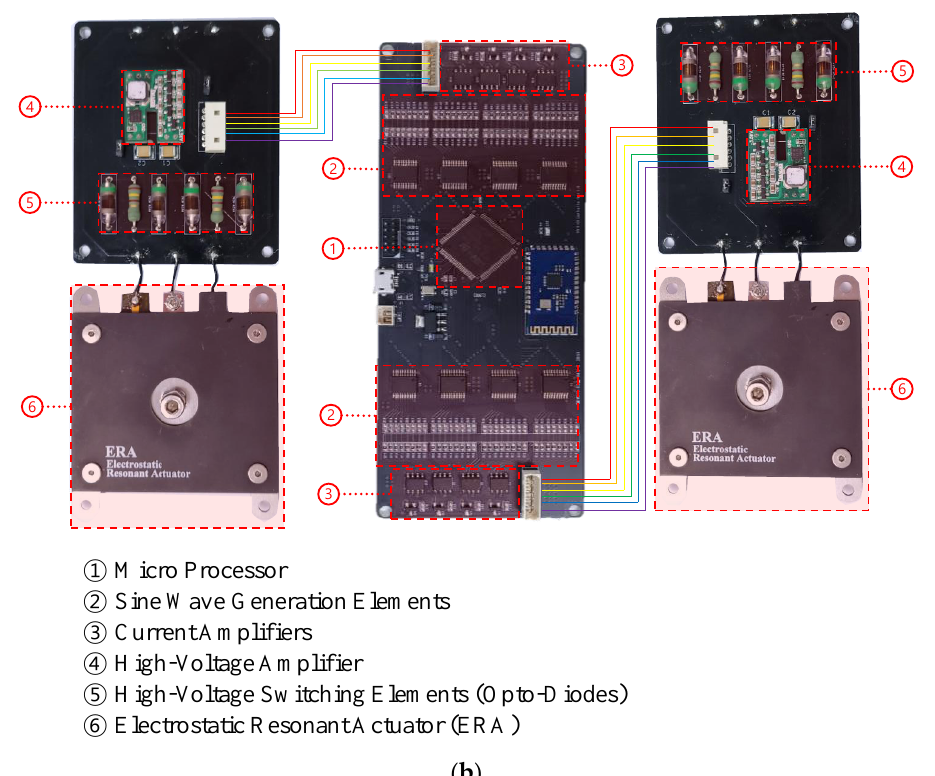
Figure 2. High-voltage controller for two ERAs: ( a ) Schematic of a circuit diagram capable of generating and controlling two channels of high-voltage signals; ( b ) fabricated microprocessor-based high-voltage controller and two connected ERAs.